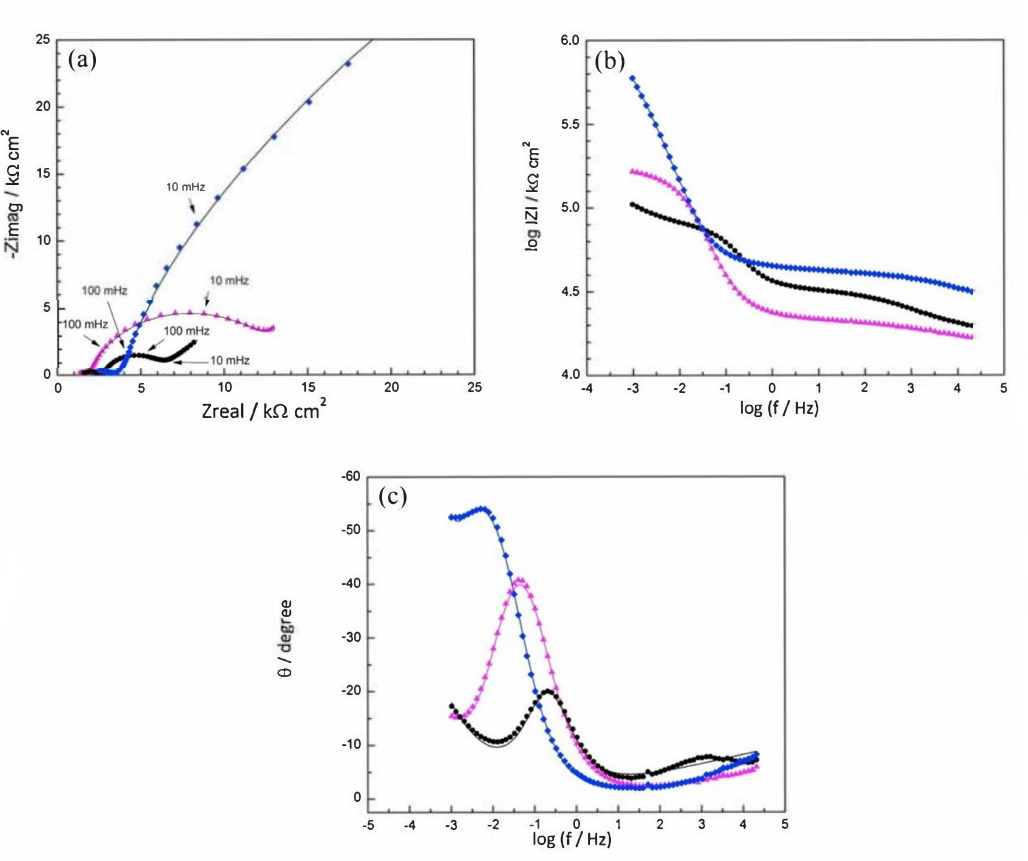
Figure 4. EIS spectra for mix designs: Mix A ( ), Mix B ( ) and Mix C ( ), registered after 720 days of exposure. Points represent the experimental EIS data and lines show the fitting results: ( a ) Nyquist plot, ( b ) and ( c ) Bode plots [56]. Reproduced with permission from Yohai, L. et al., Electrochim. Acta; published by Elsevier, 2016.